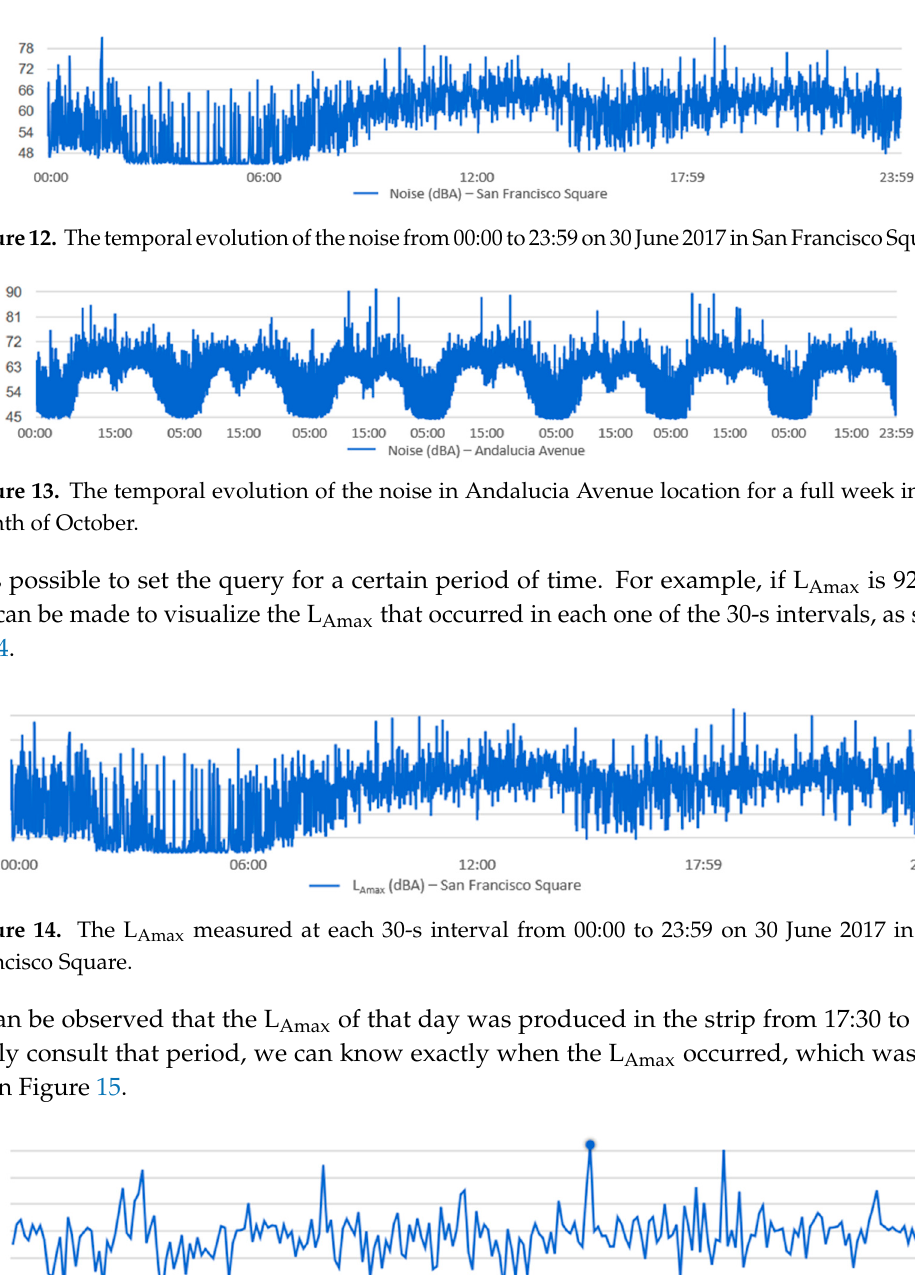
Figure 15. The L Amax measured at each 30-s interval from 17:30 to 19:30 on 30 June 2017 in San Francisco Square.